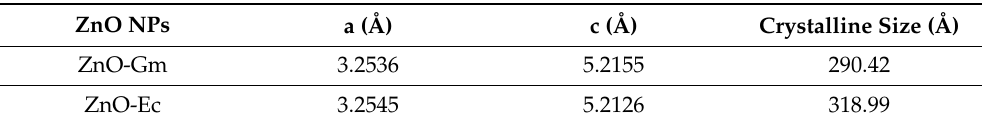
Table 1. The lattice parameters and crystalline sizes for synthesized ZnO NPs determined from XRD data after Rietveld refinement.